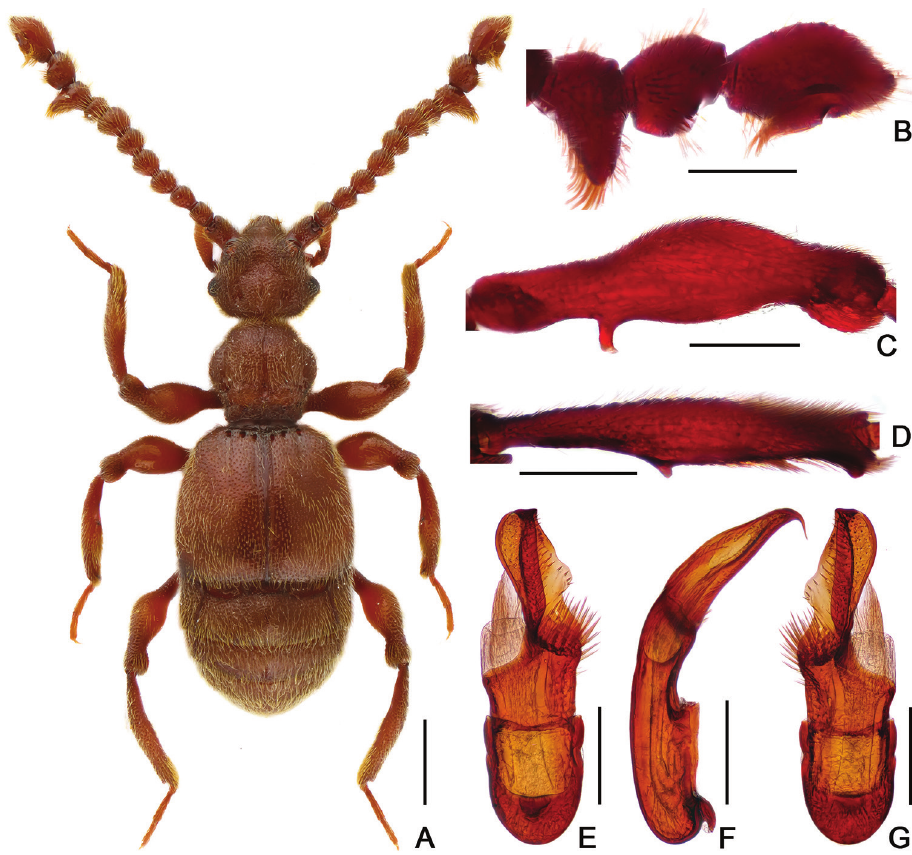
Figure 10. Diagnostic features of Batrisodes zethus , male. A Dorsal habitus B Antennal club C Mesotro- chanter and mesofemur D Mesotibia E–G Aedeagus, in ventral ( E ), lateral ( F ), and dorsal ( G ) views. Scale bars: 0.5 mm ( A ); 0.2 mm ( B–G Batrisodes zhouchaoi sp. n. http://zoobank.org/31133048-37CD-4B88-BBAE-76BFBA4D73B5